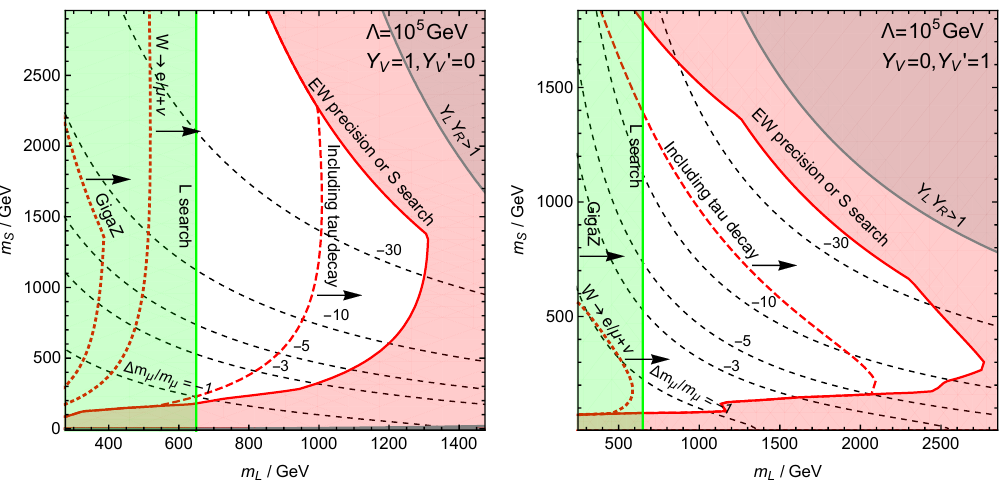
Figure 5 . Constraints on the model for a fixed ∆ a µ = (2 . 51 − 0 . 59) × 10 − 9 . The part of parameter space without significant tuning for obtaining the muon mass can be probed by the LHC search for the doublet vector-like lepton L . All of the parameter space can be probed by future lepton colliders.